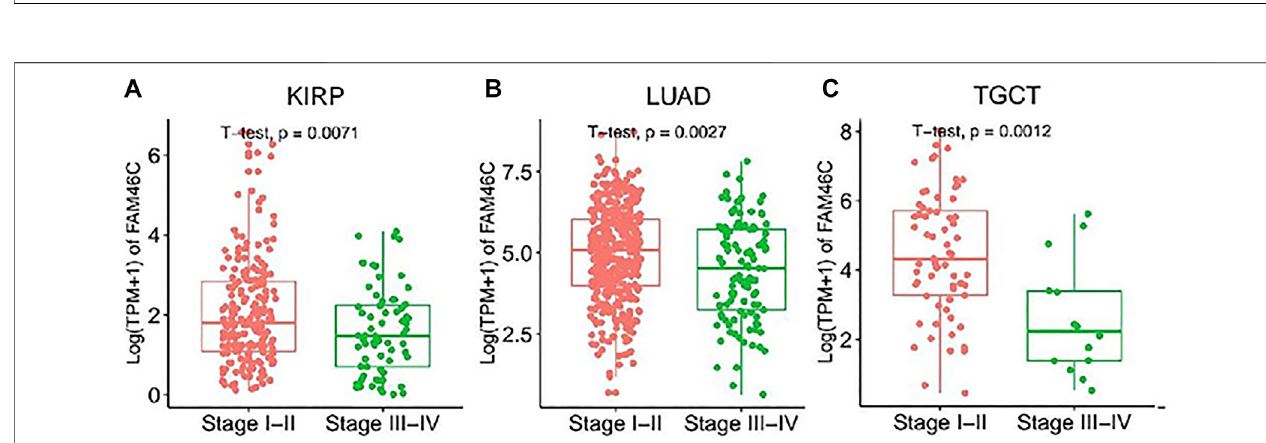
FIGURE 2 | FAM46C expression in pan-cancer with different World Health Organizatio stages. (A – C) Comparison of early and late expression of FAM46C in different tumours.